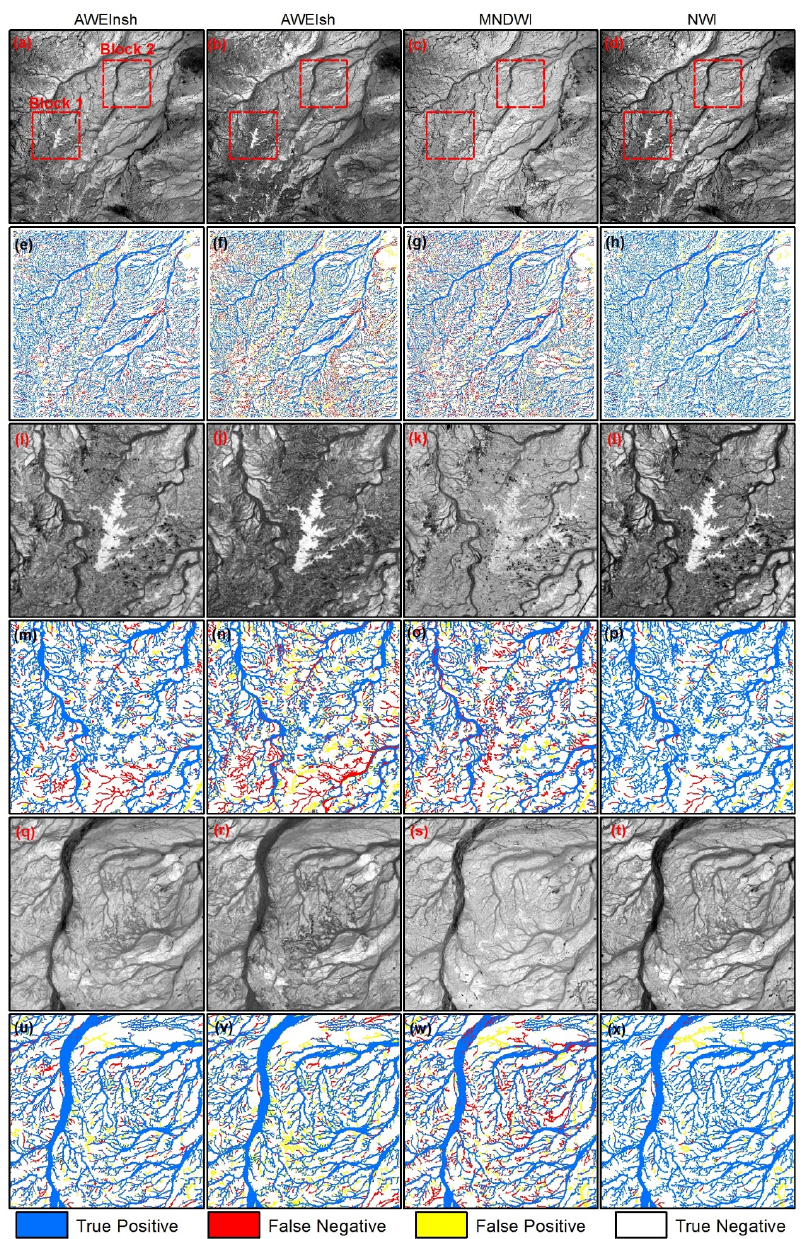
Figure 8. ( a – d ) WI images of Study Area 1; ( e – h ) wadi extraction results for Study Area 1; ( i – l ) WI images of Block 1; ( m – p ) wadi extraction results for Block 1; ( q – t ) WI images for Block 2; ( u – x ) wadi extraction results for Block 2.